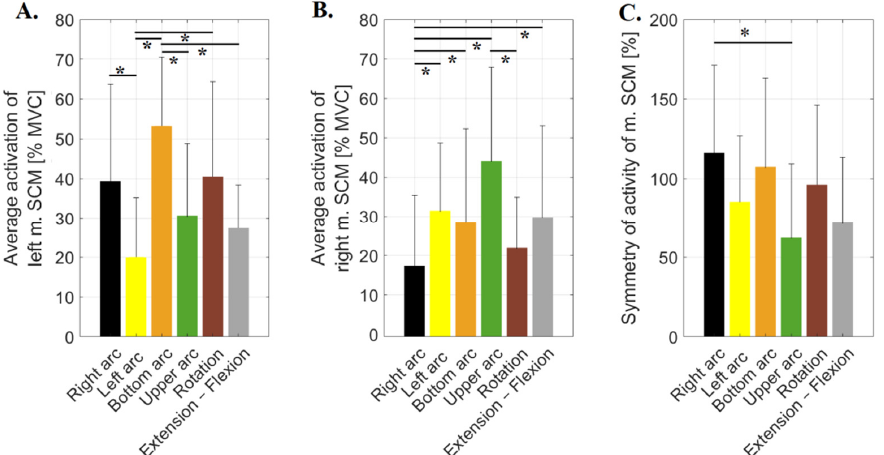
Figure 7. Average values of muscle activity recorded during six motions (right arc, left arc, bo tt om arc, upper arc, rotation and extension–Flexion) for ( A )—left sternocleidomastoid muscle (m. SCM), ( B )—right sternocleidomastoid muscle and ( C )—symmetry index calculated for the sternocleidomastoid muscles during the analysed motions; * p ≤ 0.05.